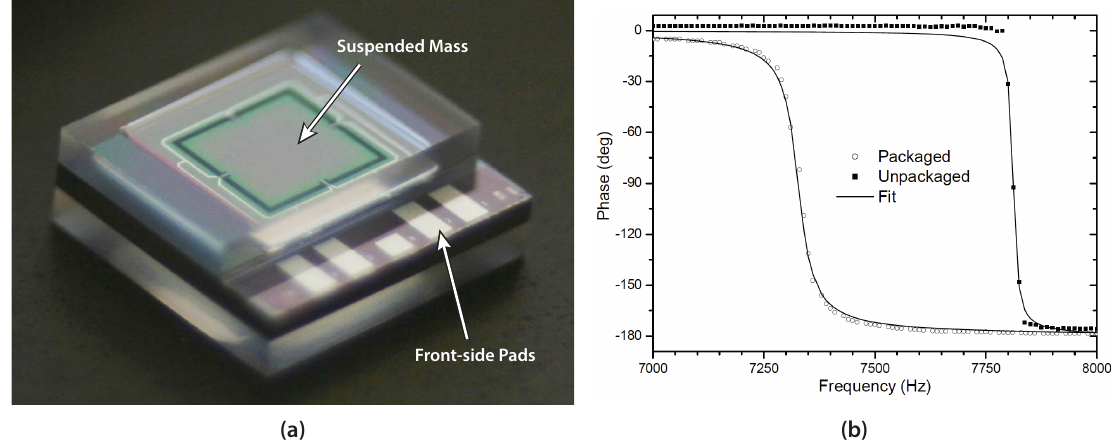
Figure 4. ( a ) Fully fabricated vibration sensor with front and back-side glass capping. The front-side pads were revealed by partial dicing of the capping substrate; ( b ) Phase response plot of an unpackaged and packaged vibration sensor. The phase response was fitted to a second order system given in Equation (1) to find the Q -factors and resonant frequencies. Originally published in Proceedings of